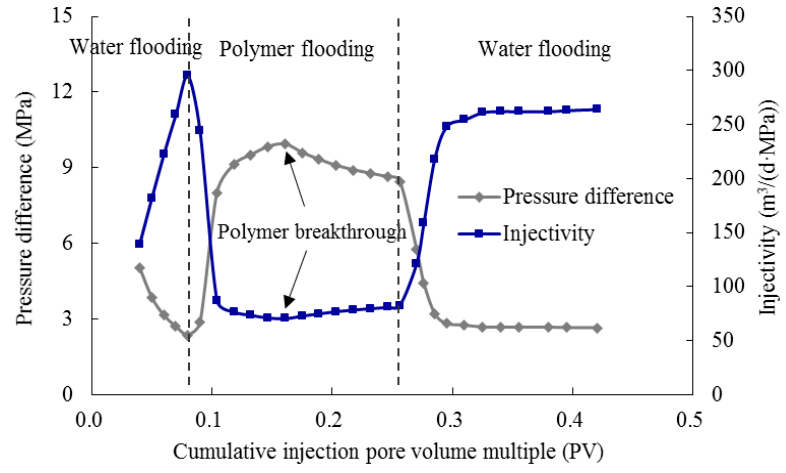
ff erence and commingled injectivity at di ff erent Figure 7. Change law of pressure difference and commingled injectivity at different stages. Figure 7. Change law of pressure di